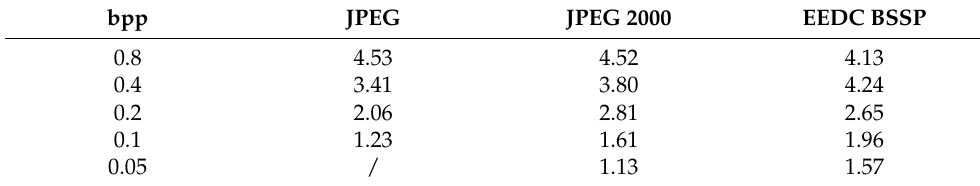
Table 23. MOS values for image horse at various compression